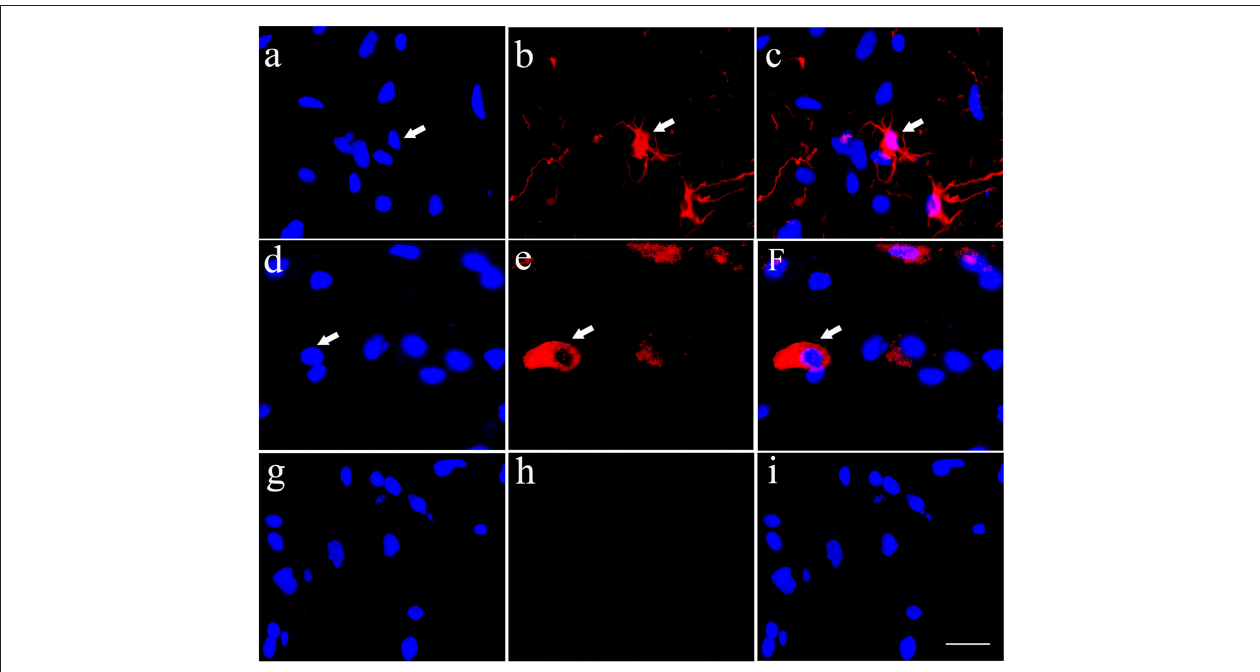
FIGURE 2 | Cultured HSCs differentiate towards neurons and glia cells in vitro . Cultured HSCs differentiated toward neurons (A–C) and astrocytes (D–F) , which were identified by immunofluorecent staining of Tuj1 and aldehyde dehydrogenase 1 family, member L1 (ALDH1L1) antibodies, respectively, while the negative control showed no positive staining (G–I) . Bar = 25 µ m. White arrows represented the positive cells.